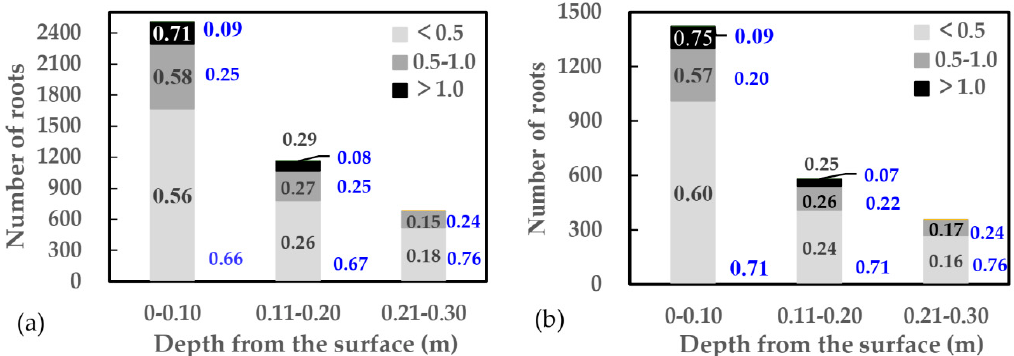
Figure 6. Root distributions in the three depth ranges of the experimental blocks for ( a ) AS and ( b ) AM. The number within each color of the three columns represents the percentage of roots in each sub-layer of the soil-root layer (i.e., the sum of the numbers in each color is 100%). The number outside of the columns represents the percentages of three root diameters in each sub-layer (i.e., the sum of these numbers along each column is 100%). The scaling of the y-axis is different between ( a , b ).